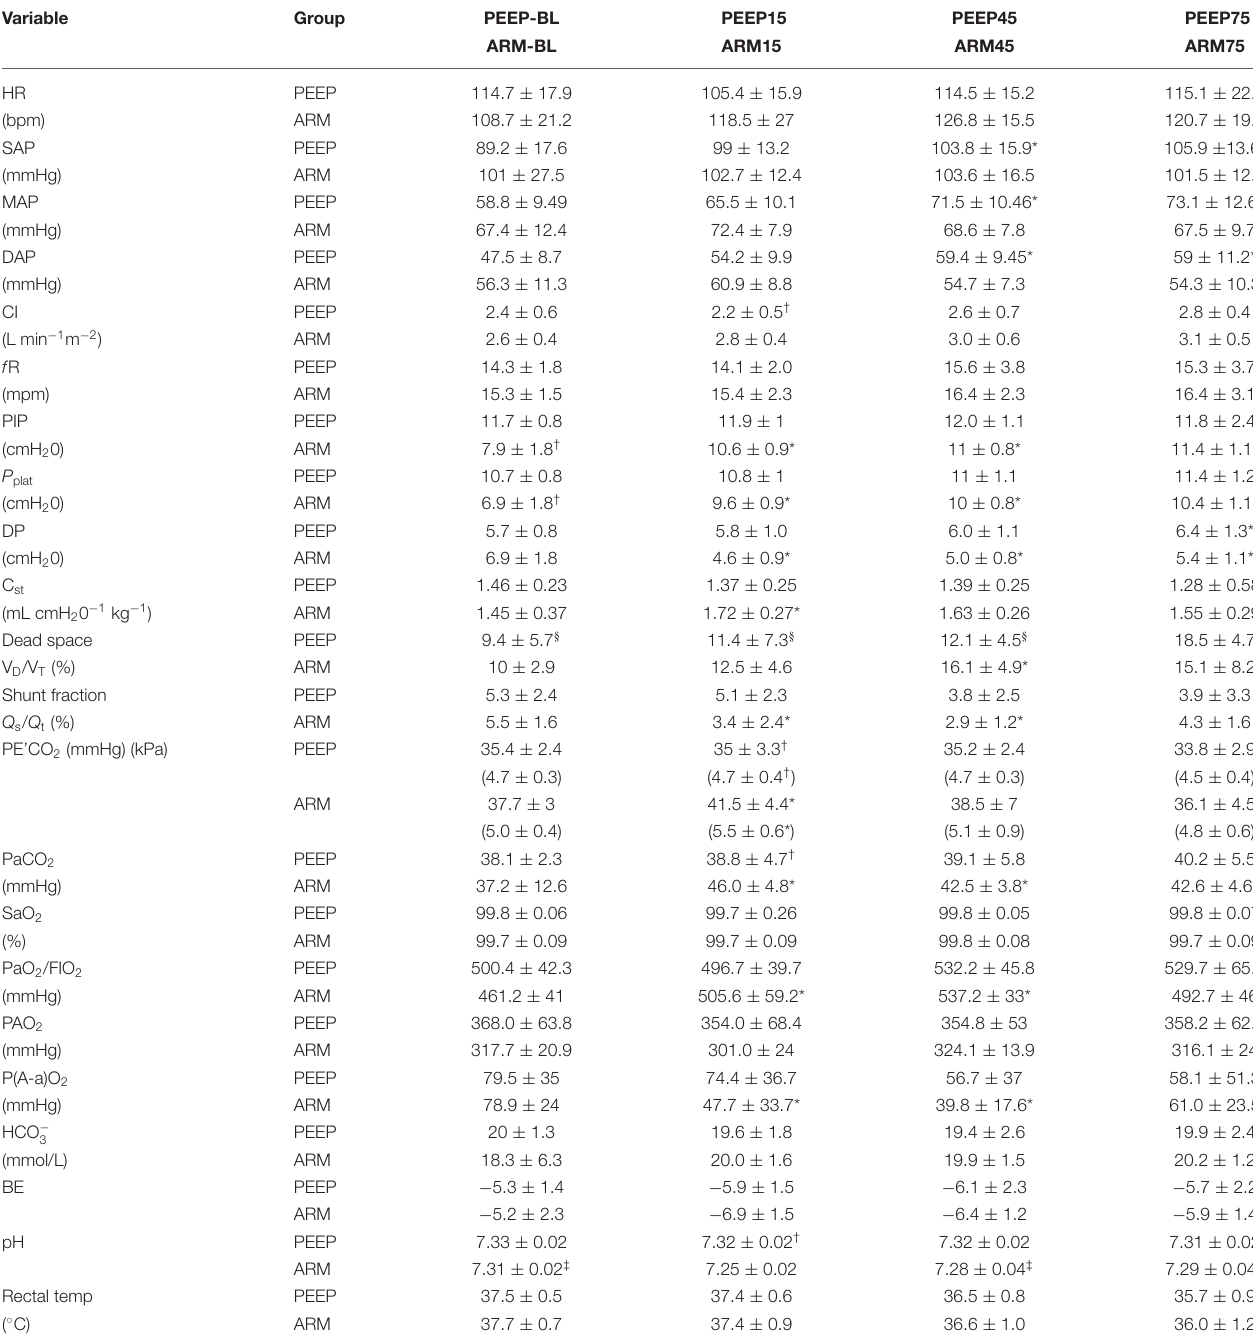
TABLE 1 | Measurements of cardiovascular variables, ventilation and respiratory mechanics in isoflurane-anesthetized dogs mechanically ventilated with tidal volume of 8mL kg − 1 submitted to recruitment maneuver (ARM group, n = 11) or without recruitment maneuver (PEEP group, n = 10) and use of 5 cm H 2 0 of positive end expiratory pressure